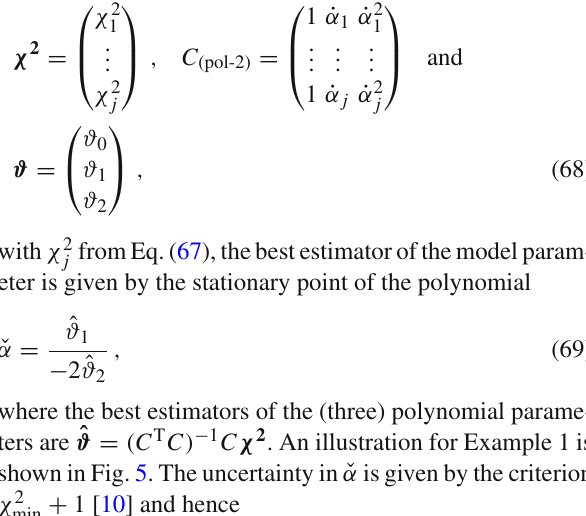
of templates for the univariate Linear Template Fit is only